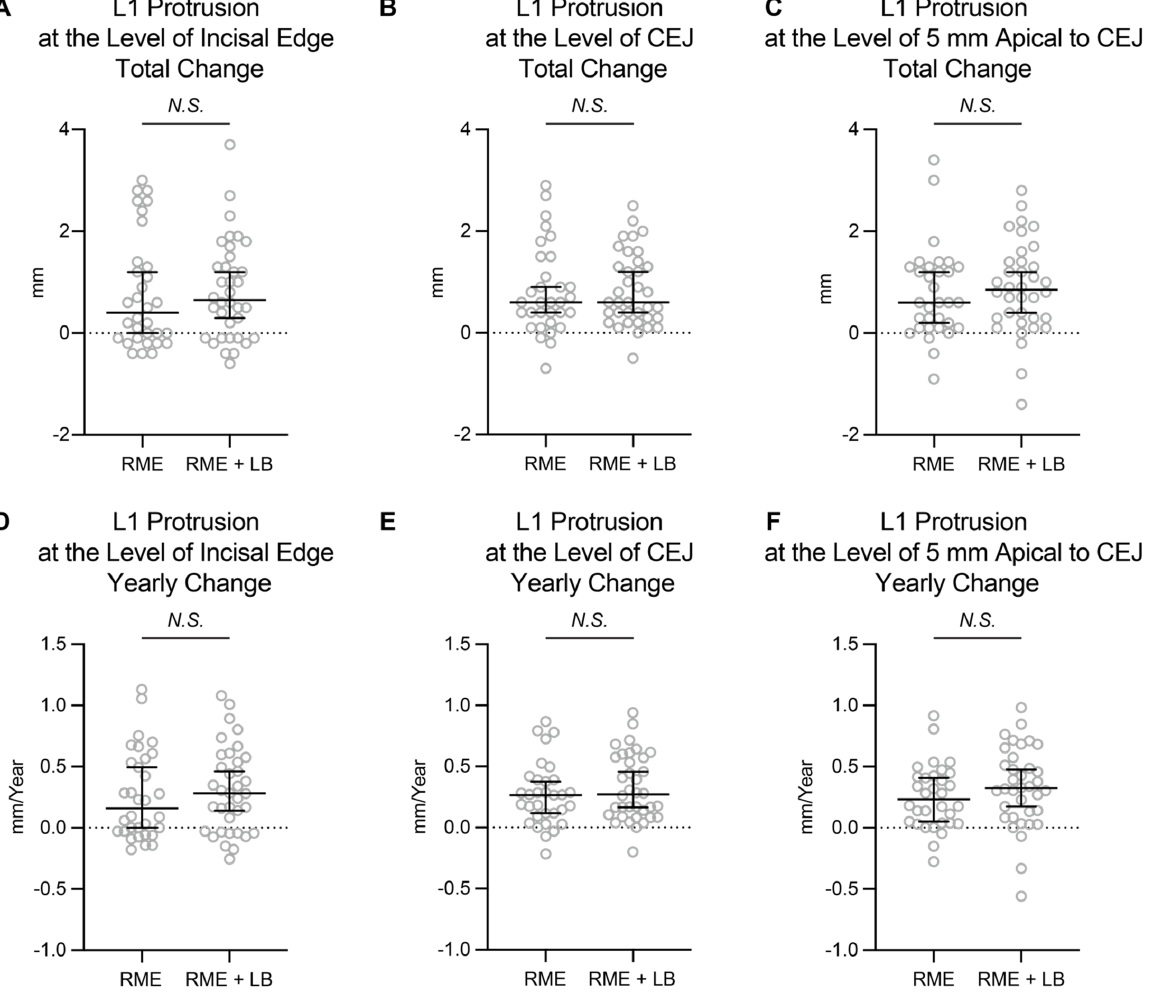
Figure 3. The total change and yearly change of the mandibular central incisors anterior–posterior position. The data are presented as raw data overlapped with Median ± 95% confidence interval. CEJ: cementoenamel junction; RME: rapid maxillary expansion; LB: lip bumper; N.S. : not significant.